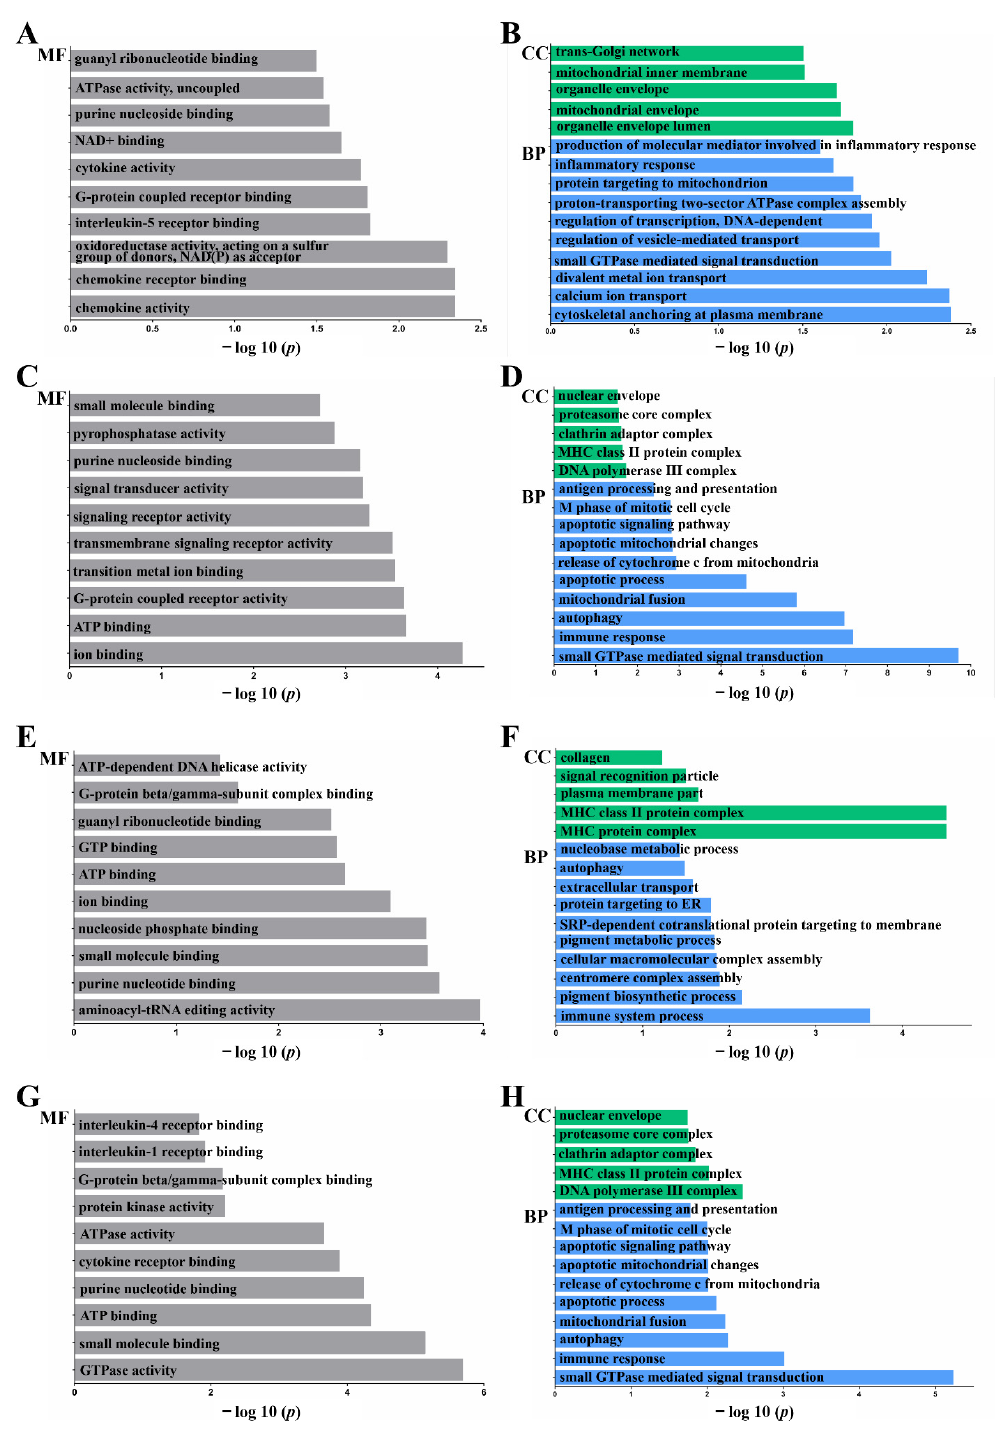
Figure 2. GO Terms of LncRNA Target mRNAs. GO annotation of biological process (BP), cellular component (CC), and molecular function (MF) terms of differentially expressed genes. Co-location prediction of lncRNAs between ( A , B ) S.T group and control, ( C , D ) S.T group and AA + S.T group. GO analysis was performed on mRNAs identified by searching for genes within 100 kb upstream and downstream of the lncRNA ( n = 3, p < 0.05). Prediction of co-expression of lncRNAs between ( E , F ) S.T group and control, ( G , H ) S.T group and AA + S.T group. GO analysis was performed on mRNAs identified by analyzing expression correlations among multiple samples ( n = 3, p <